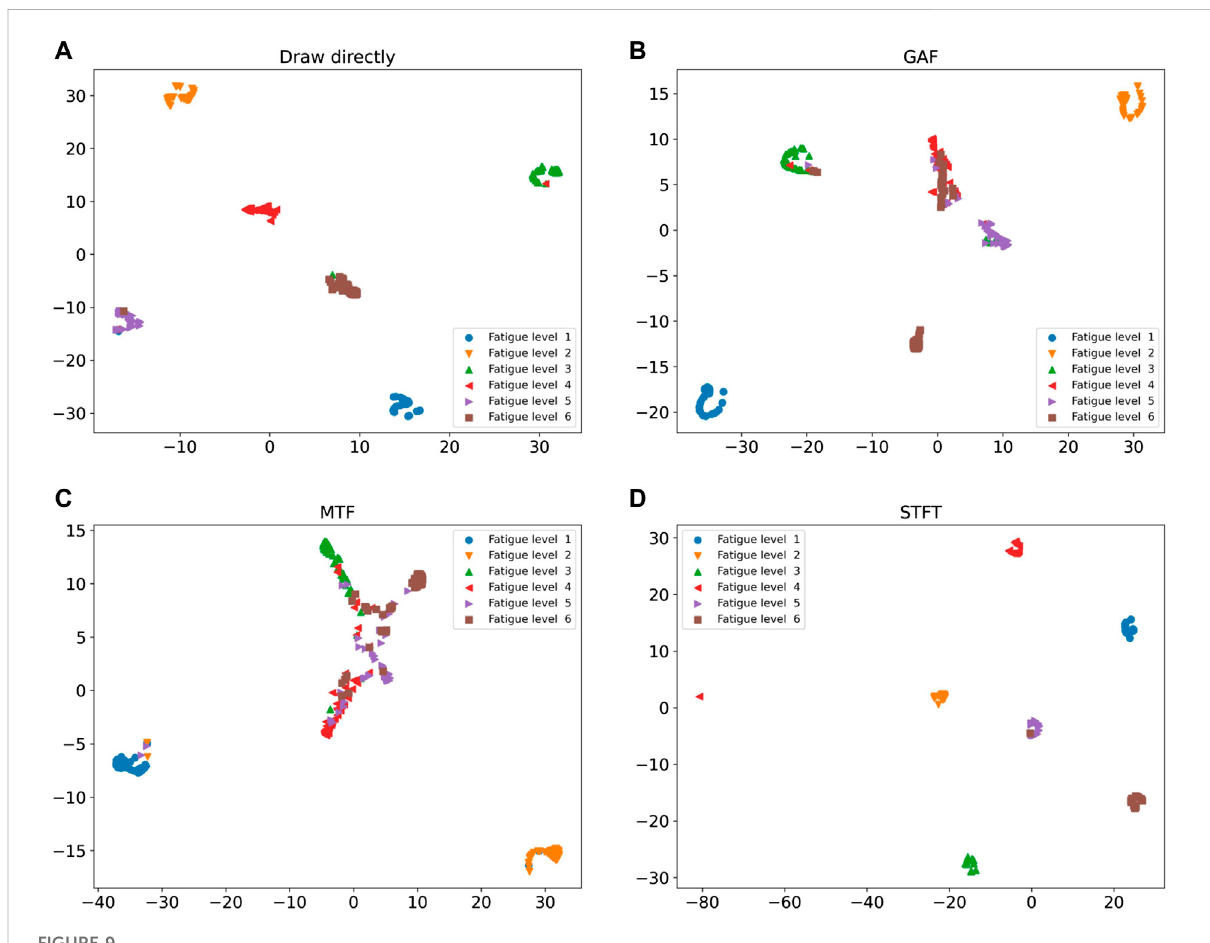
FIGURE 9 Cluster analysis of four methods: (A) Draw directly, (B) GAF, (C) MTF, (D)